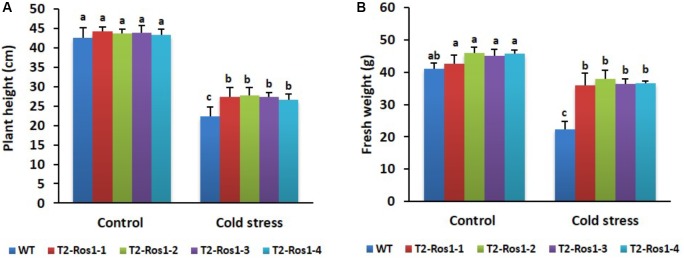
Comparisons of (A) plant height and (B) fresh weight in 10-week-old WT and four independent T2-Ros1 lines under cold stress (0°C) and normal growth conditions (22°C). Error bars indicate the standard errors (SE) of means of three replicates. Means with different letters are significantly different (DMRT, p < 0.05).